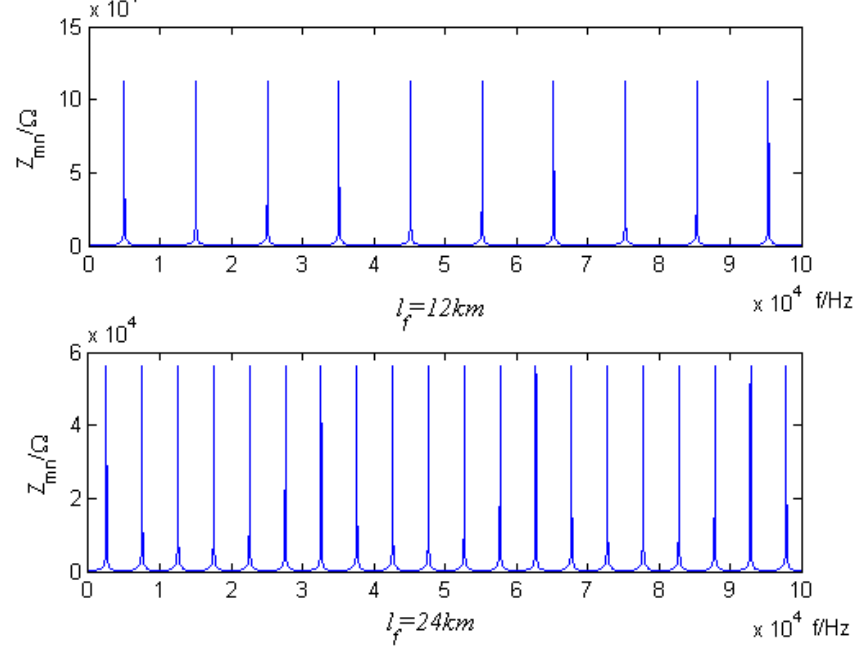
versus frequency with different l mn